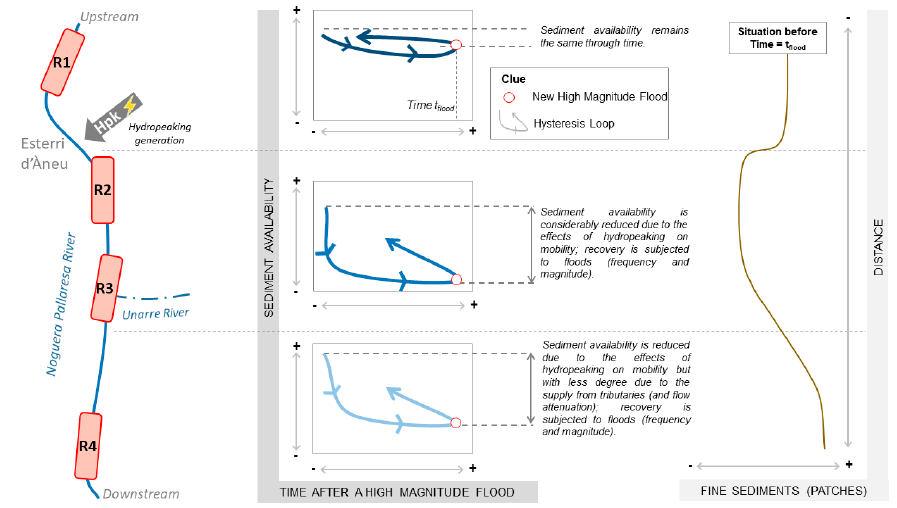
Figure 14. Conceptual model of spatial and temporal river-bed dynamics in hydropeaked reaches based on the observed bed mobility patterns (Figure 12).